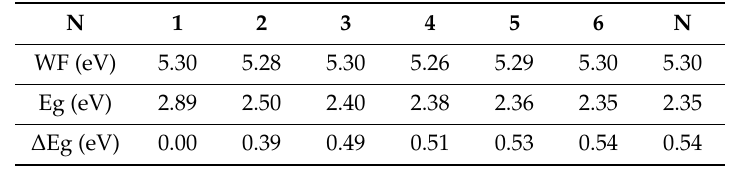
Table 1. Work function (WF) and band gap (Eg) of two-, three-, four-, five- and six-layer 2D g–C 8 N 6 computed with HSE06 functional. The band-gap di ff erences ( ∆ Eg) between the multilayers and mono-layer g–C 8 N 6 are shown.